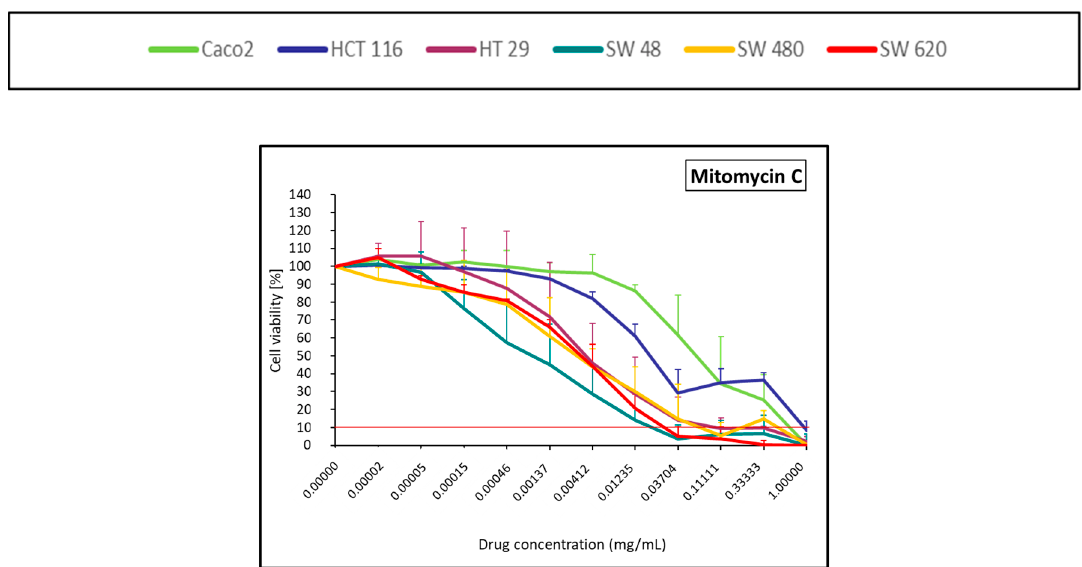
Figure 4. Colorectal cancer cell line viability curves (mean ± standard deviation) after a 30 min contact time with an alkylating antibiotic (mitomycin C). The horizontal red line represents 10% of cell viability. The results are presented after normalization with the control cells (untreated condition).